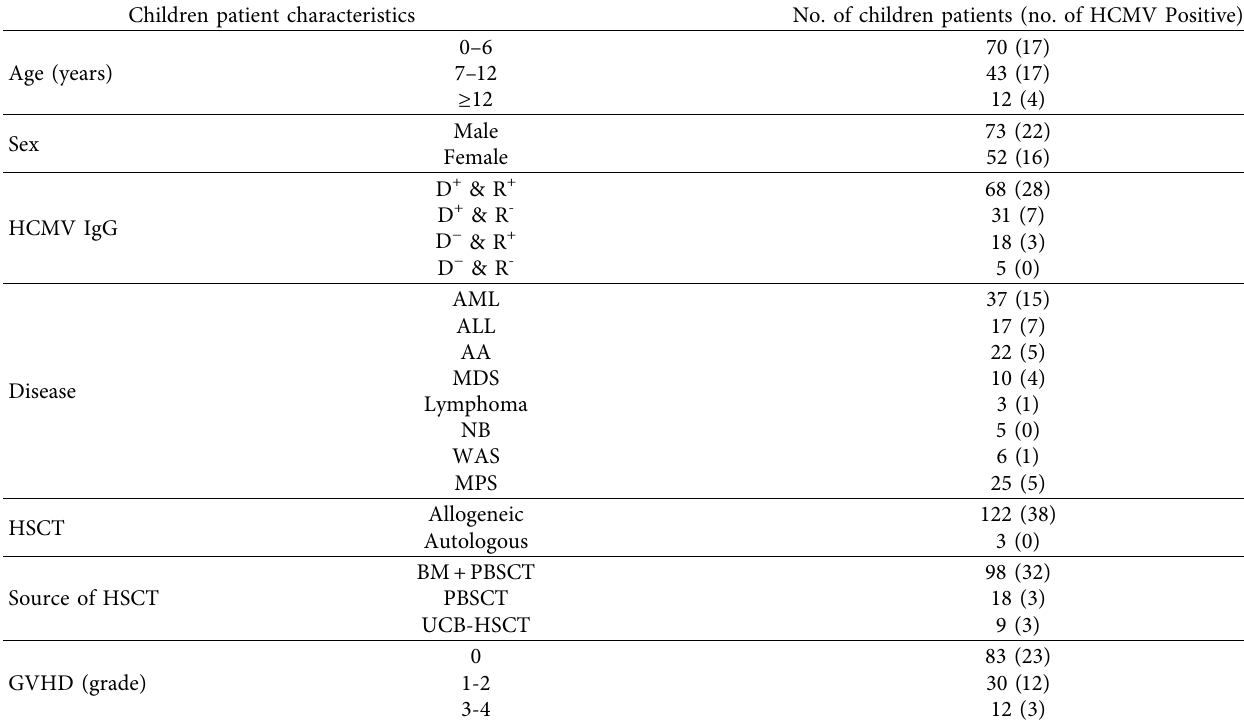
Table 2: Characteristics of 125 children following HSCT.